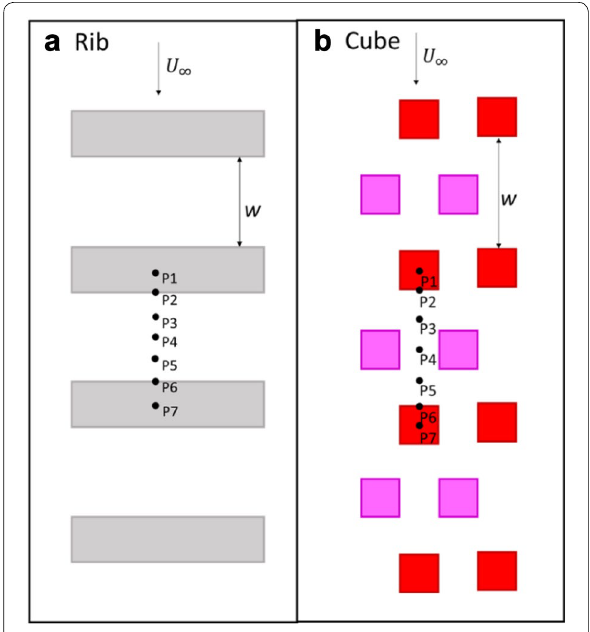
Fig. 2 Plan view of a rib‑type and b cube‑type arrays. Also shown are the sampling positions of the vertical profiles over rough surfaces (black solid